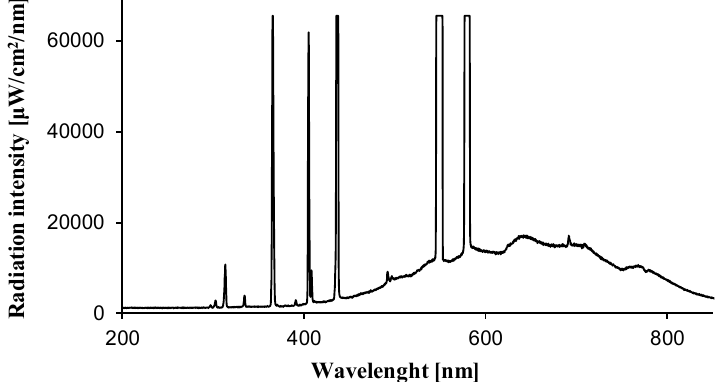
Figure 6. Emission spectra of the artificial solar light source (Ocean Optics Inc., Largo, FL, USA).